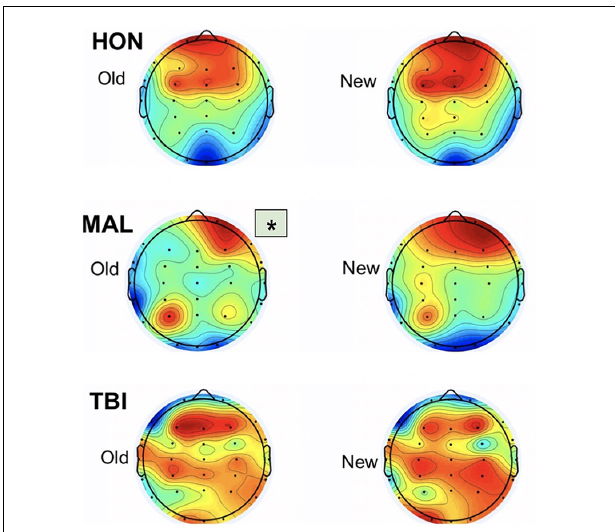
FIGURE 4 | Topographic maps from the three testing groups representing averaged activity from 250 to 400 ms. Group differences were found only during old items. Asterisk indicates significant differences from other groups.